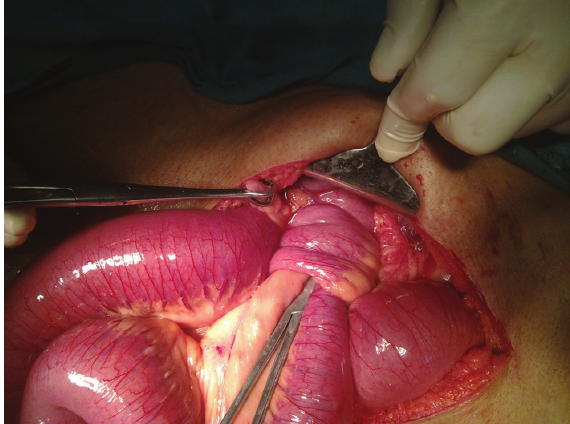
Figure 1: Terminal ileum telescoping into distal ileum and subse- quently into ascending colon. Appendix is seen in normal position.